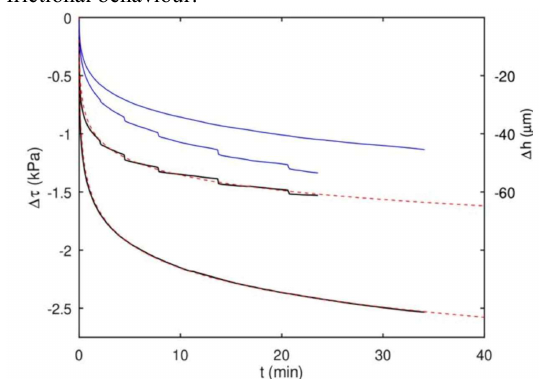
Fig. 2. Shear stress relaxation (two lower curves in black) with their logarithmic fit (dashed red lines) and height decrease (two upper curves in blue) versus holding time. Powder: Tor5. Upper and lower curves: small cell,  = 10.2 kPa. Middle curves: big cell,  = 10.5 kPa.